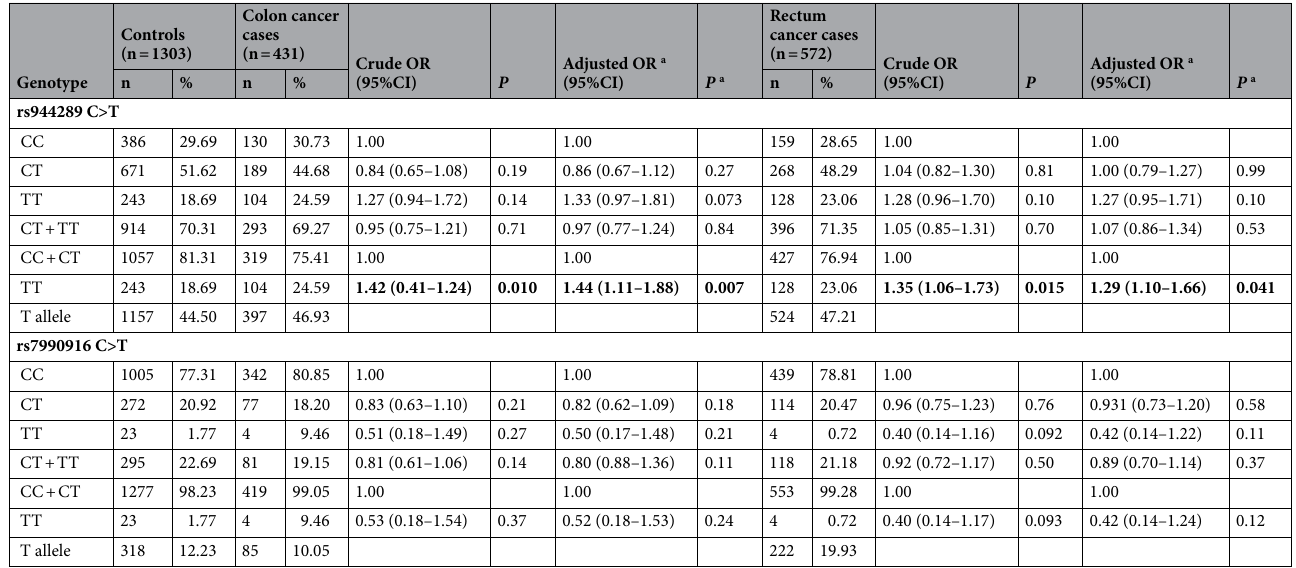
Table 6. Stratified analyses between LncRNAs rs944289 C>T and rs7990916 C>T polymorphisms and CRC risk by site of tumor. a Adjusted for age, sex, smoking status, alcohol use and BMI status. Significant values are in